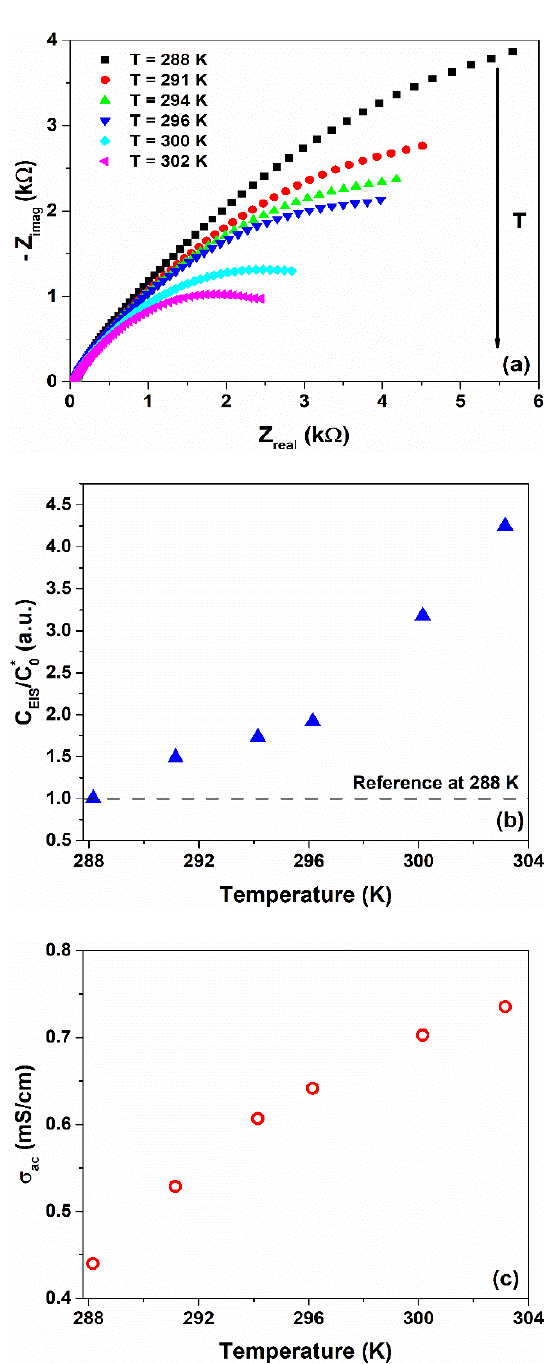
Figure 3. ( a ) Impedance spectra measured in a temperature range between 288 and 303 K. Temper- ature dependence of the ( b ) normalized capacitance and ( c ) ionic conductivity extracted from the impedance spectra by using Equations (3) and (4), respectively.